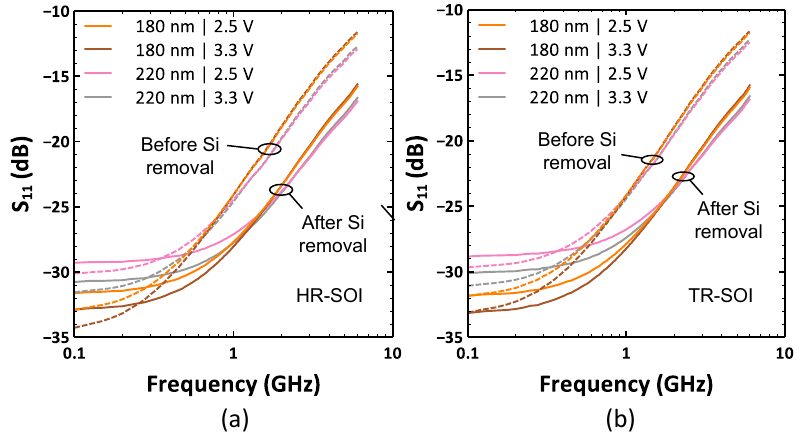
Figure 12. S 11 curves depicting the reflection losses of the switch before and after substrate removal for different gate lengths and V biasON values ( a ) HR-SOI; ( b ) TR-SOI.